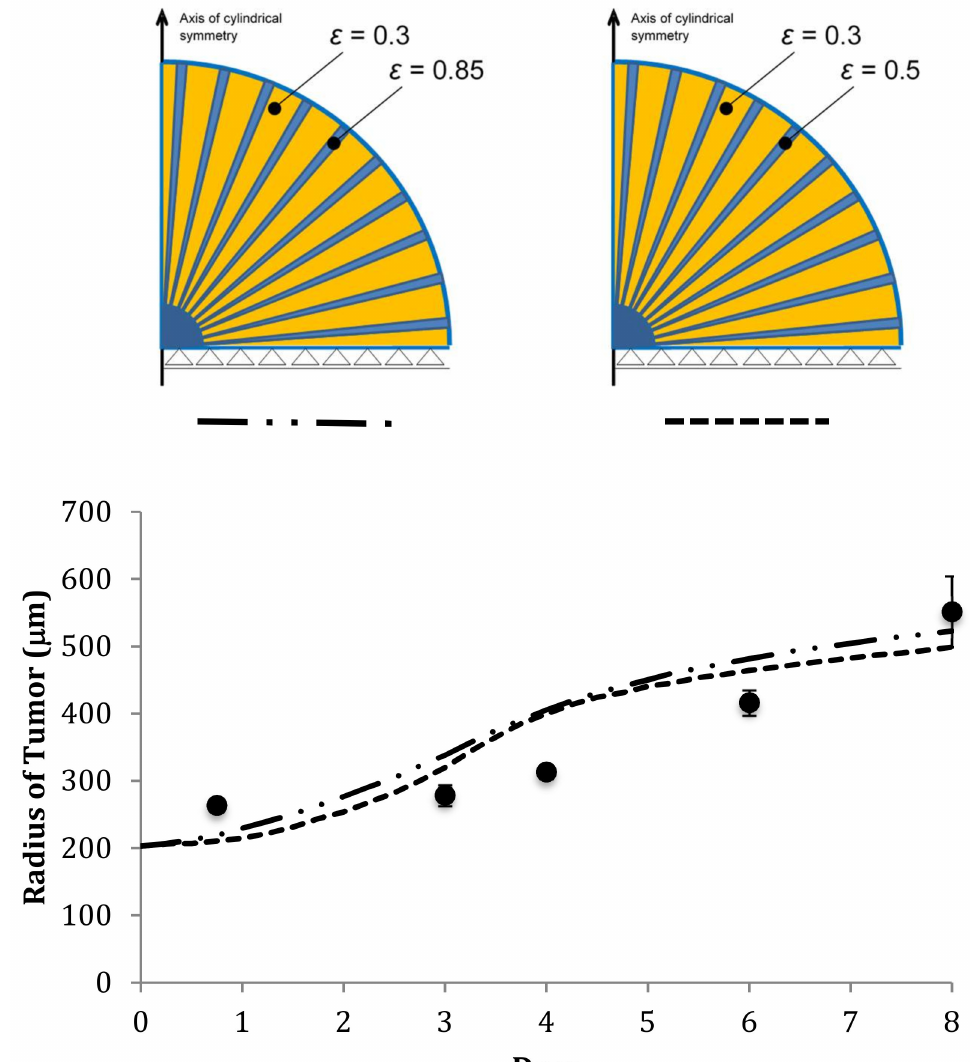
Figure 11. Radius of the tumor against time for di ff erent ECM porosity distributions. Initially, the tumor spheroid is located within the central blue area, with ε = 0.85 (low ECM content). Externally at this central area, ECM has a nonhomogeneous porosity characterized by alternating radial sectors with ε = 0.3 and ε = 0.85 (dashed—two dots line) and ε = 0.3 and ε = 0.5 (dashed line). The two configurations provide similar results in terms of tumor growth. However, the configuration with the overall lowest porosity ( ε = 0.5 / 0.3) predicts a slightly lower tumor growth. Dots represent the same average values of the experimental data and related error bars of Figure